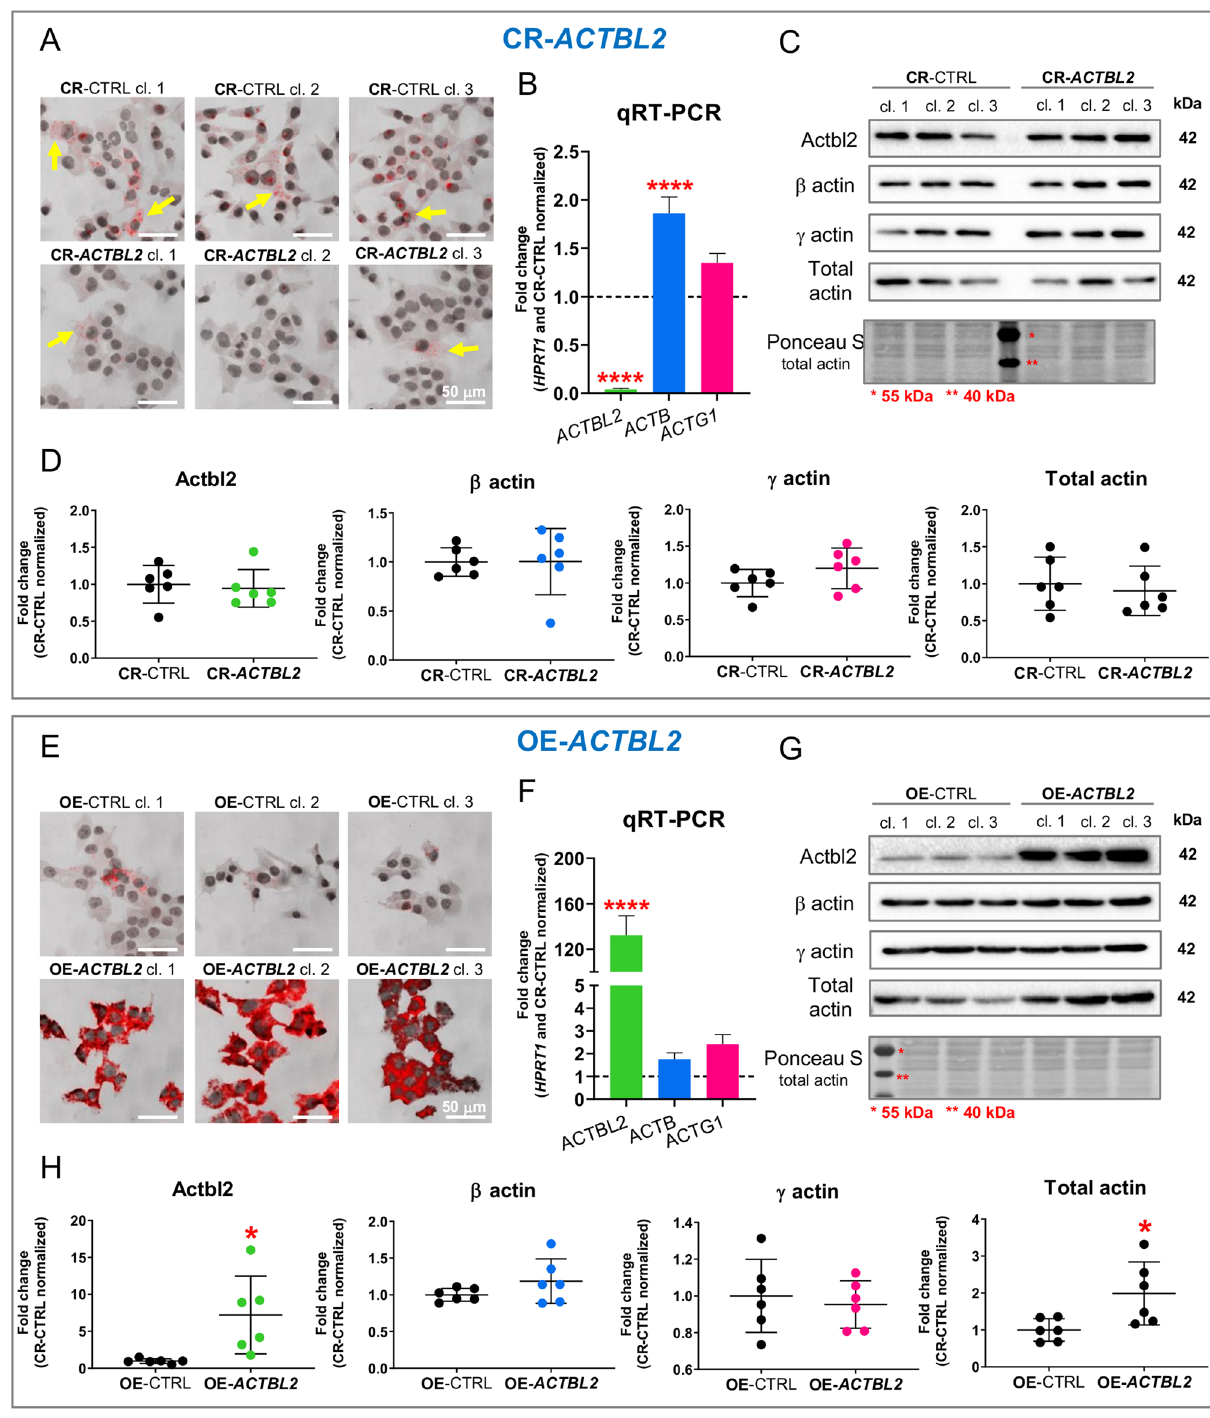
Figure 6. Successful knockout of ACTBL2 and overexpression of actbl2 in A375 cells. ( A , E ) RNAscope analysis of CR-CTRL, CR- ACTBL2 , OE-CTRL, and OE- ACTBL2 clones to detect mRNA coding for actbl2. Yellow arrows highlight cells with detected mRNA coding for actbl2. ( B , F ) qPCR analysis of expression of ACTBL2 , ACTB , and ACTG1 in control clones and clones either devoid of actbl2 or actbl2 overexpressing (n = 3). Dotted lines represent expression levels for control cells. ( C , G ) Western blot analysis of lysates of CR-CTRL, CR- ACTBL2 , OE-CTRL, and OE- ACTBL2 cells. Membranes were incubated with antibodies directed against actbl2, β-actin, γ-actin, and total actin. Corresponding Ponceau S stainings of membranes and uncropped membranes are shown in Fig. S14. Thirty micrograms of protein was loaded in every lane. ( D , H ) Densitometric analyses of Western blots are presented in ( C , G ), respectively. Results are expressed as the mean ± SD (D,H) or mean ± SEM (B,F); p ≤ 0.05 (*), p ≤ 0.0001